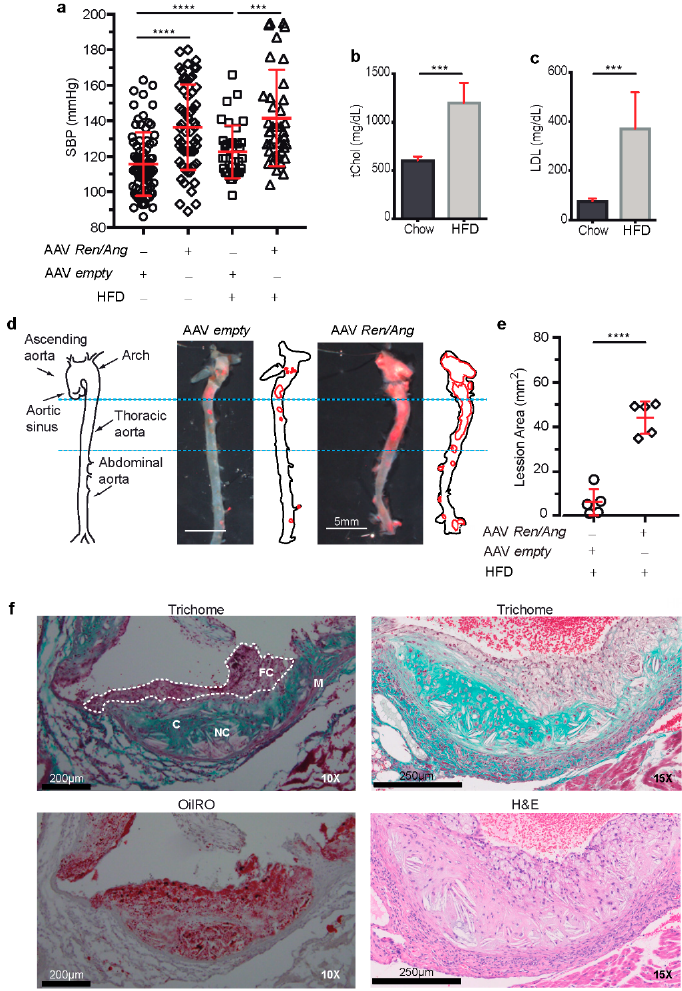
Figure 2. Elevated blood pressure (BP) induces atheroma plaque development in ApoE − / − mice. ( a ) SBP in ApoE − / − mice 6 weeks after injection with AAV- Ren/Ang or AAV-empty vector and after subsequent maintenance for a further 10 weeks on a high fat diet (HFD) (n = 15 animals per group). Data are mean ± SEM. *** p < 0.001 and **** p < 0.0001, 2-way ANOVA followed by Bonferroni post-test. ( b ) Serum total cholesterol and ( c ) serum low-density lipoprotein (LDL) cholesterol in AAV- Ren/Ang -injected ApoE − / − mice fed standard chow or the HFD for 10 weeks starting 6 weeks after AAV injection. ( d ) Schematic representation of the aorta. Aortic sinus, ascending aorta, arch, thoracic aorta, and abdominal aorta are indicated with black arrows. Representative complete aortas from AAV-empty control and AAV- Ren/Ang -injected ApoE − / − mice stained with Oil Red O. Aortas were extracted 10 weeks after starting the HFD. Scale bar, 5 mm. ( e ) Lesion area in aortas stained as in D. Data in ( b , c , e ) are mean ± SEM. *** p < 0.001, **** p < 0.0001, Student t -test. ( f ) Representative Masson’s trichrome, Oil Red O, and H&E staining of the aortic sinus in HFD-fed AAV- Ren/Ang ApoE − / − mice. FC, foam cells; NC, necrotic core; C, collagen lesions; M, tunica media. Scale bars, 200 µ m (10 × ) and 250 µ m (15 ×